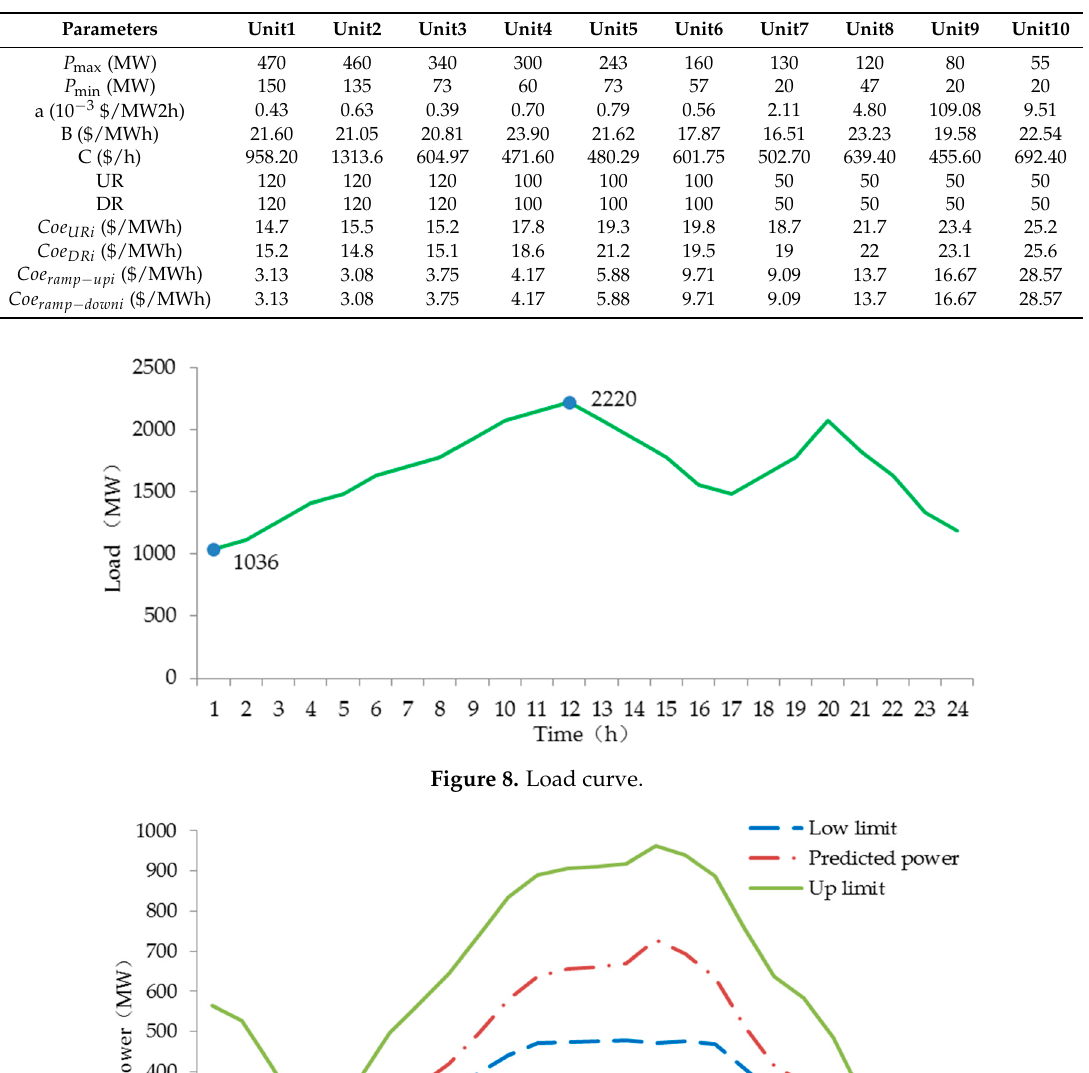
Table 2. Operating data for the 10-unit system